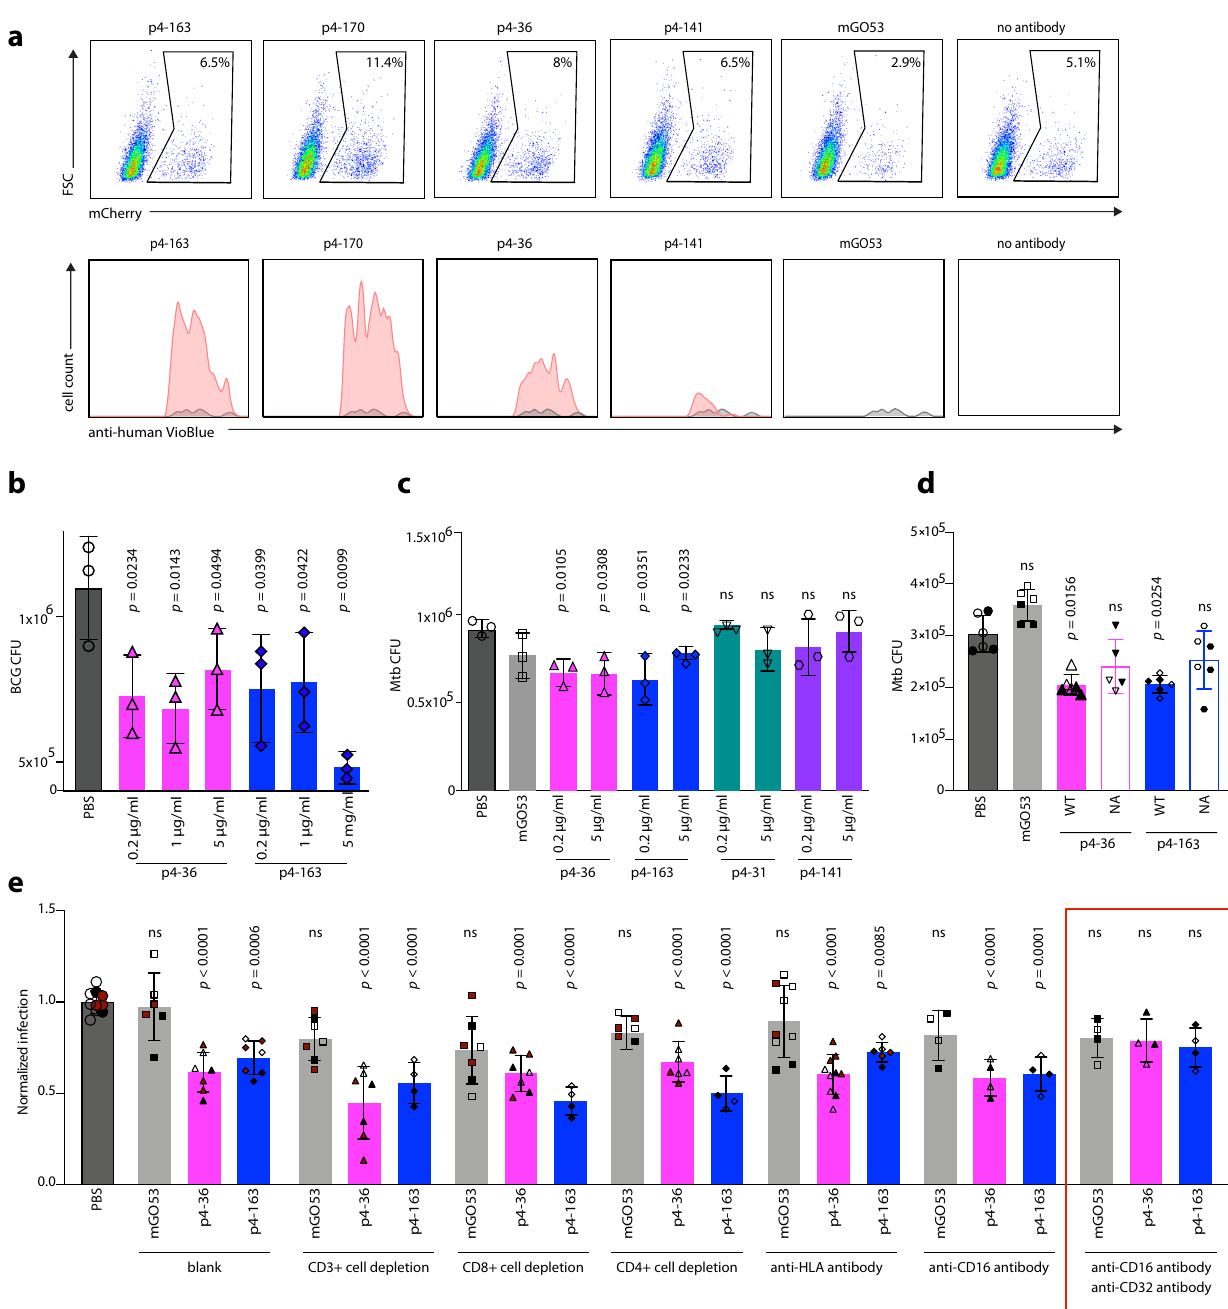
Fig. 3 Anti-PstS1 mAbs inhibit Mtb in culture. a Upper panel: gating strategy of H37Ra-infected macrophages, mCherry positive. PMA-differentiated THP- 1 cells preincubated with mAbs p4-163, p4-170, p4-36, p4-141, and the isotype control mAb mGO53 20 . For each treatment n = 90,000 cells were analyzed by fl ow cytometry. Lower panel: histograms showing the frequencies of intracellular antibody-bound bacteria as detected by anti-human VioBlue antibody staining. For each mAb, the binding histogram is shown in red and compared to the isotype control histogram, which is depicted in a gray overlay. b , c Activity of anti-PstS1 mAbs at indicated concentrations in a human whole blood mycobacterial growth inhibition assay (MGIA) after 96 h of infection with BCG or pathogenic Mtb, respectively. CFU was determined in n = 3 biological repetitions. d Activity of anti-PstS1 mAbs (5 µ g/ml) used as IgG1 (named “ WT ” , full columns) or as N279A Fc variants (named “ NA ” , empty columns) in MGIA. Black and clear shapes correspond to two independent experiments. CFU was determined in n = 5 – 6 biological repetitions. e Activity of anti-PstS1 mAbs (5 µ g/ml) in MGIA following depletion of CD3 + T cells, CD4 + T cells, CD8 + T cells, blockade of MHC II (anti-HLA), and CD16 or CD32 or both (anti-CD16, anti-CD32, marked with a red rectangle). Black, cayenne, and clear shapes correspond to three representative independent experiments. In each experiment, the data points were compared to average CFU infection in PBS, which was normalized to 1. CFU was determined in n = 4 – 10 biological repetitions. All error bars are represented as mean ± SD. Signi fi cance was determined using a one-tailed unpaired t test ( b ), two-tailed unpaired t test ( c , d ) for black shapes ( d ), or one-way ANOVA with Tukey ’ s multiple-comparison test ( e ). All statistical analyses are relative to PBS. ns no signi fi cance. Data are representative of at least two independent